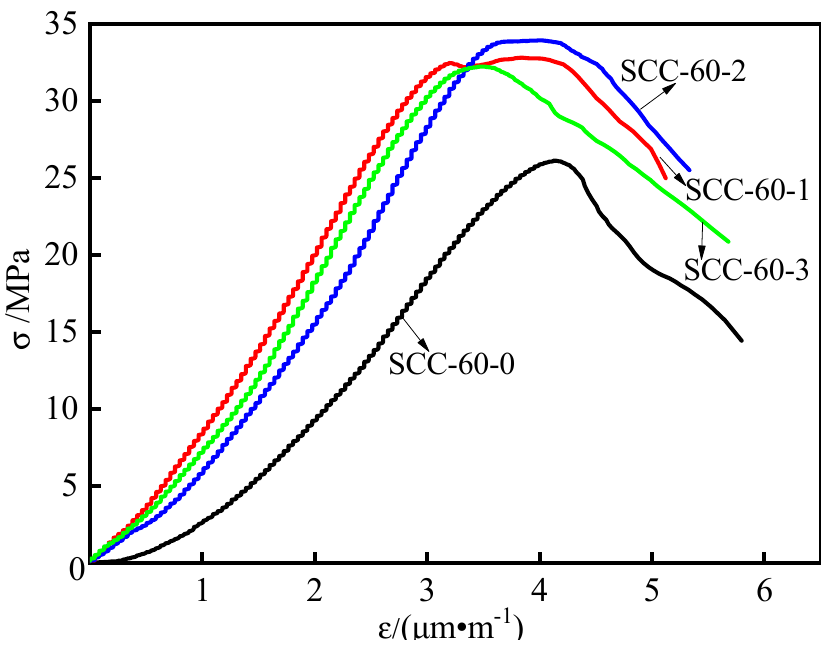
Figure 7. Stress-strain curve under axial compression.